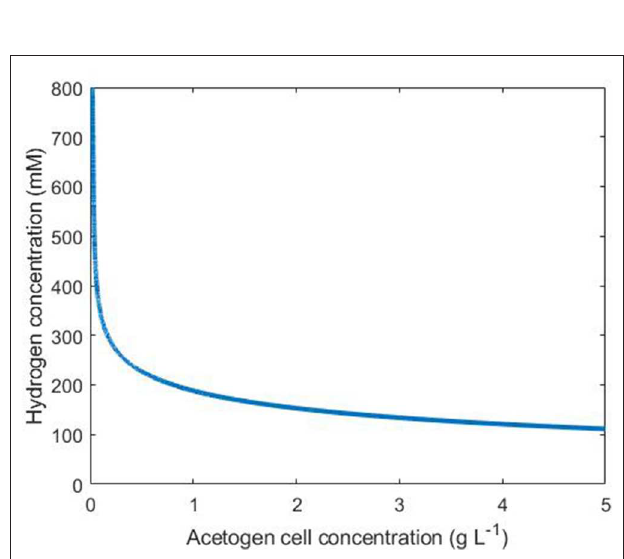
FIGURE 4 | Conditions necessary for an acetogen growth rate above 0.1g L − 1 h − 1 . The line indicates the threshold for this growth rate: any combination of hydrogen and cell concentrations falling to the upper/right side of this line results in a growth rate above